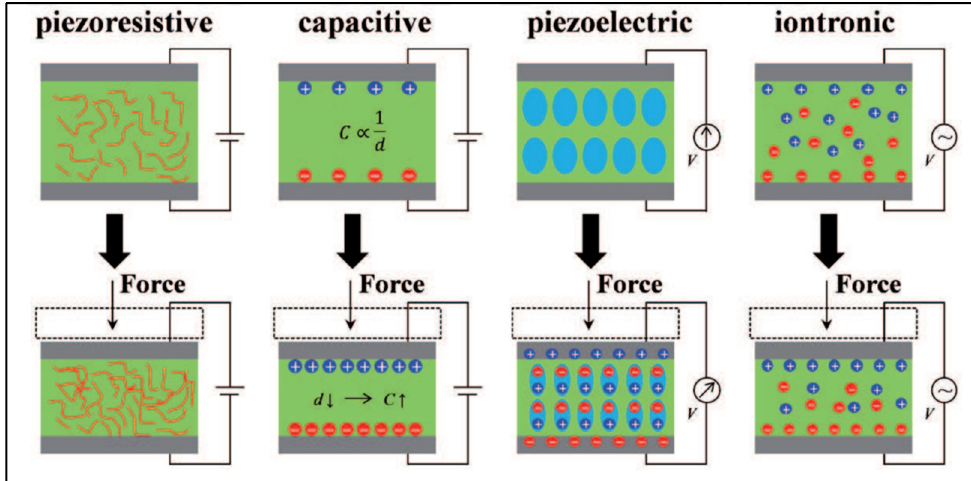
Figure 4. Schematic diagram showing different types of electromechanical transduction mechanisms. Image reproduced with permission from [8] Creative Commons Attribution 3.0 License.